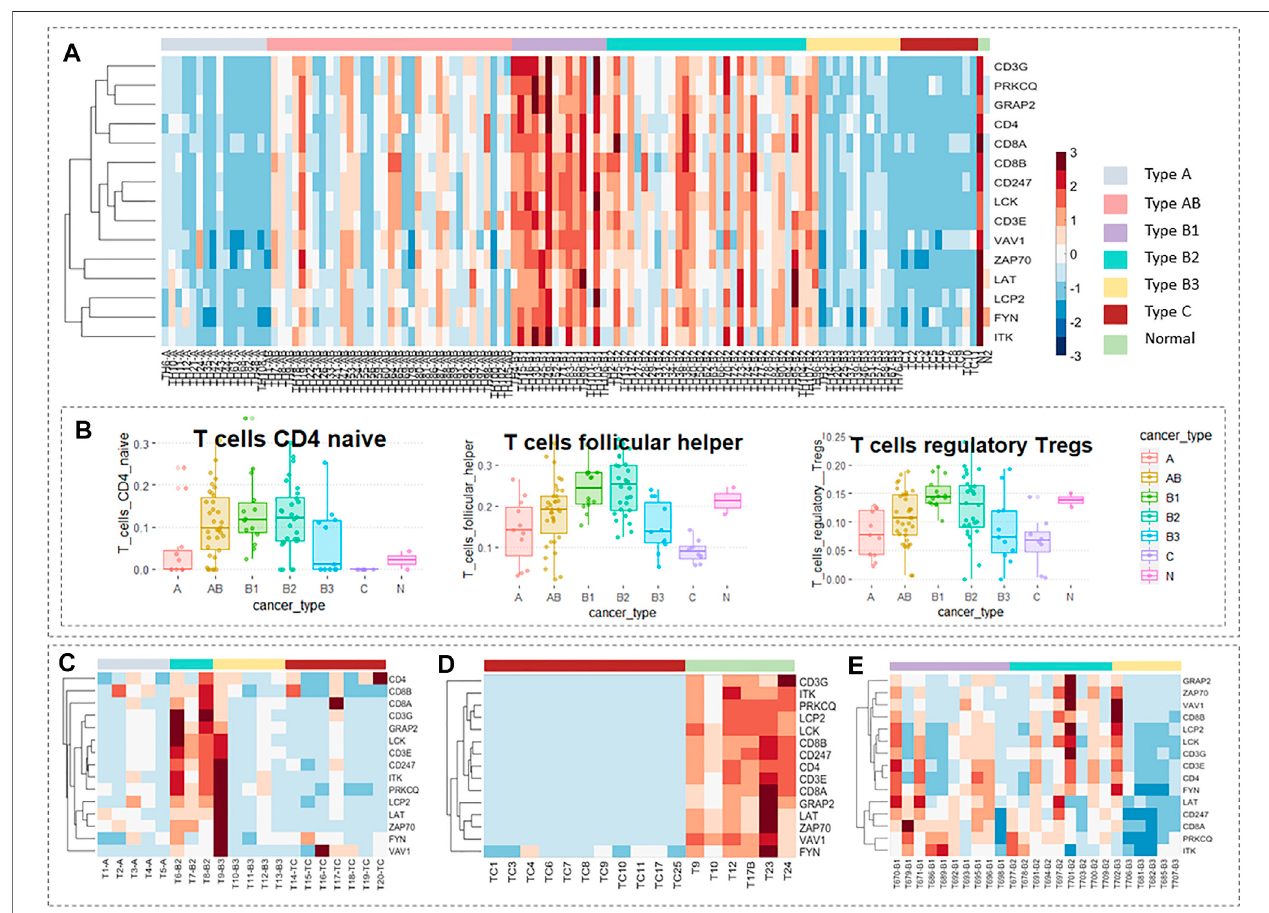
FIGURE 6 | Validation of hub genes in the expression level. Expression levels of 15 hub genes in TCGA data. (B) The proportion of T-cells of each thymic tumor subtype in TCGA data obtained by the CIBERSORT algorithm. (C) Expression levels of 15 hub genes in GSE57892 data. There are 25 samples in total, including two cases of type AB thymoma, fi ve of type A thymoma, three of type B2 thymoma, fi ve of type B3 thymoma, seven of thymic carcinomas, and three of cell line. (D) Expressionlevelsof15hubgenesinGSE177522data.Thereare19samplesintotal,including11casesofthymiccarcinoids,twocasesofthymoma,andsixcases of the normal thymus. (E) Expression levels of 15 hub genes in GSE29695 data. There are 41 samples in total, including nine cases of type AB thymoma, one of type A thymoma,10oftypeB1thymoma,nineoftypeB2thymoma,sixoftypeB3thymoma,oneoftypeA/Bthymoma,oneoftypeB1/B2thymoma,andfourofthecellline.In particular, cell lines and subtypes of less than three samples were not included in the